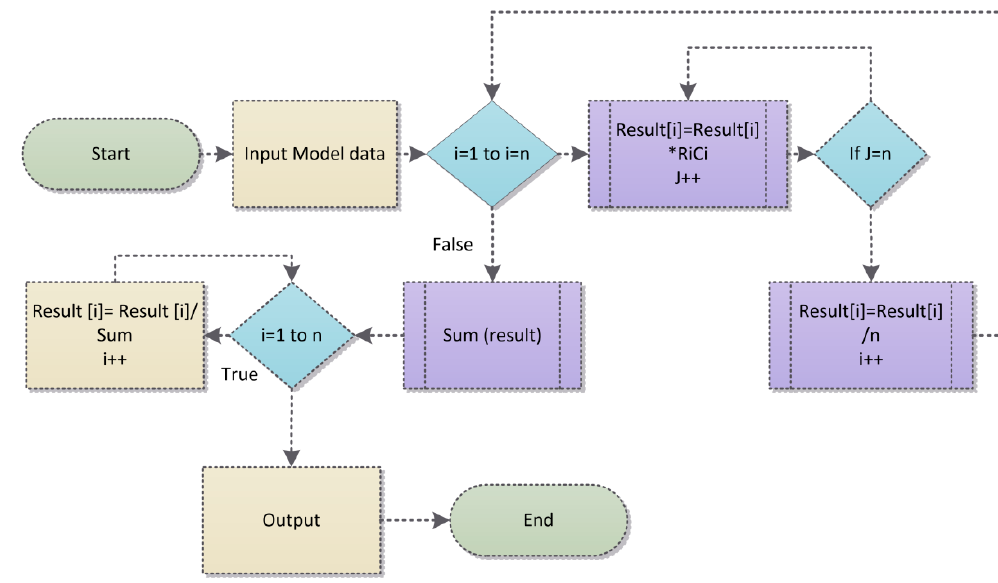
Figure 5. Flowchart of Algorithm 1 for calculating weights.